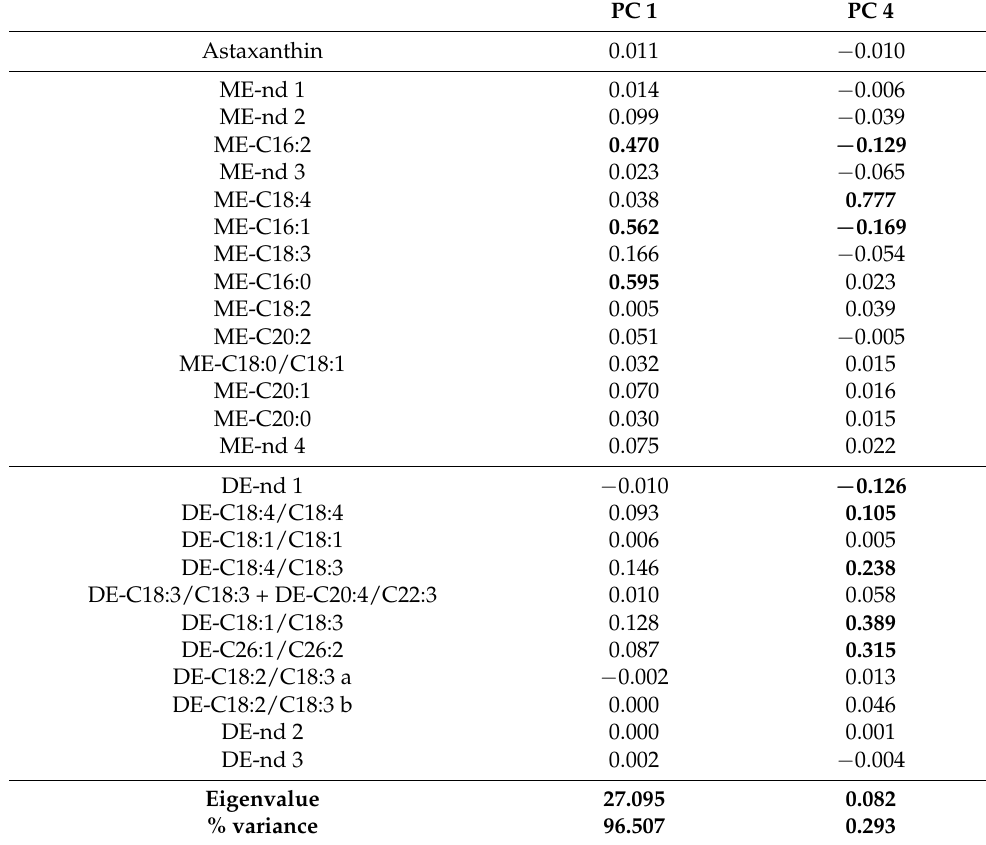
Table 3. Pooled within-group correlations between variables and PC functions of the PCA diagram (see Figure 4). For full description of the variables, see Section Material and Methods. PC